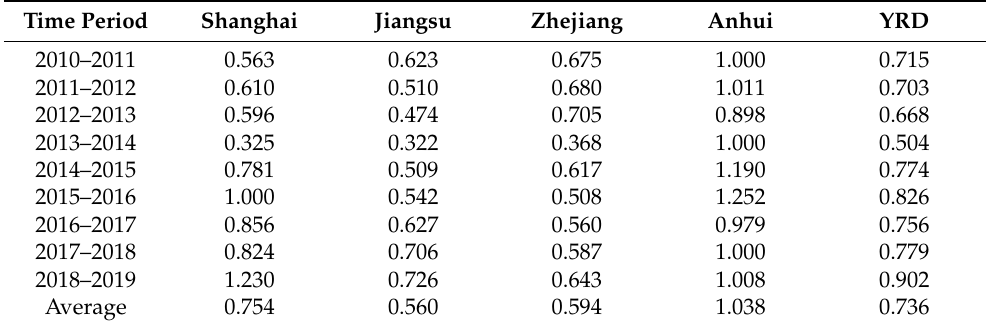
Table 7. Distribution of R&D Efficiency in high-tech Manufacturing Industry from 2010 to 2019. Time Period